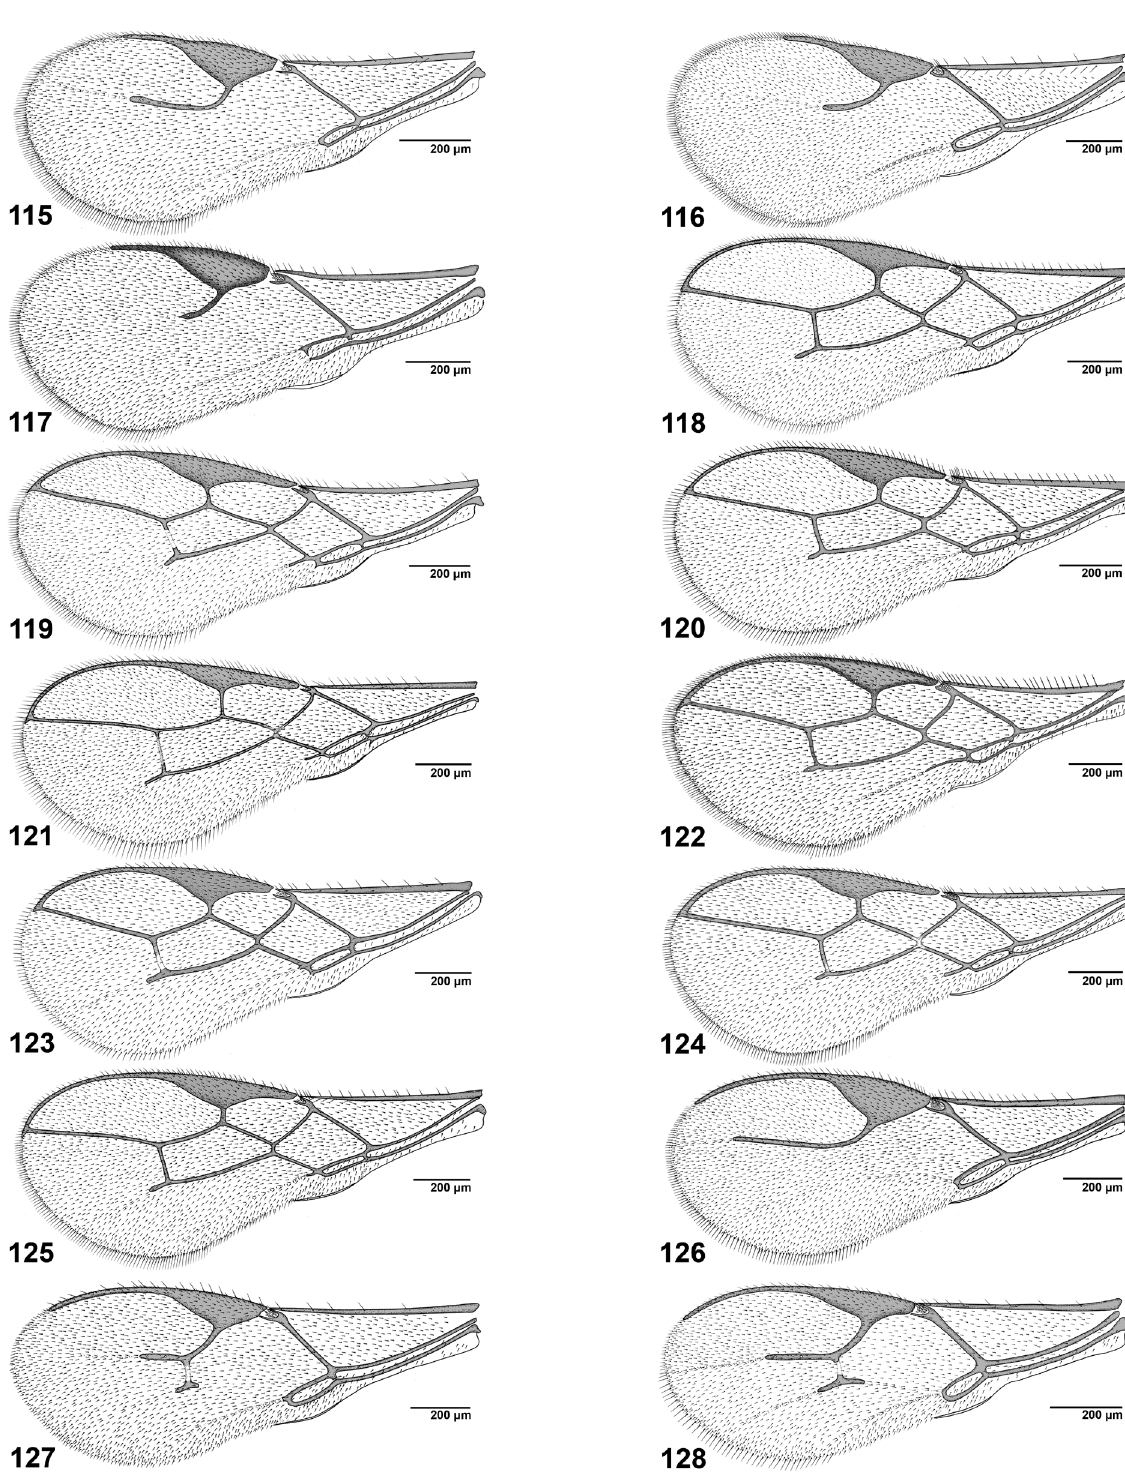
Figs 115–128. Forewing (♀): 115 . Binodoxys heraclei . 116 . Diaeretiella rapae . 117 . Diaeretus leucopterus . 118 . Ephedrus cerasicola . 119 . Ephedrus chaitophori . 120 . Ephedrus helleni . 121 . Ephedrus lacertosus . 122 . Ephedrus nacheri . 123 . Ephedrus niger . 124 . Ephedrus persicae . 125 . Ephedrus plagiator . 126 . Lipolexis gracilis . 127 . Lysiphlebus cardui . 128 . Lysiphlebus confusus